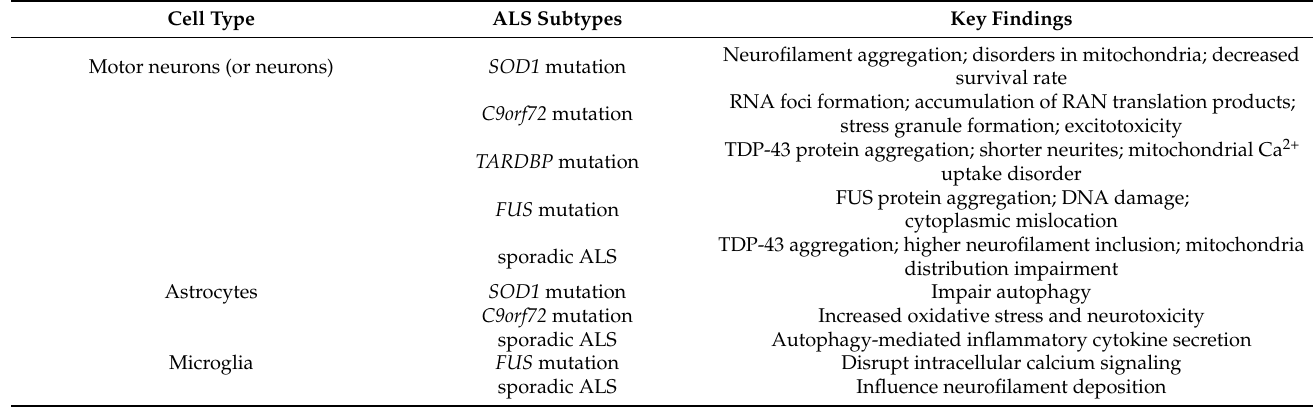
Table 1. Modeling ALS using iPSCs-derived motor neurons, astrocytes and